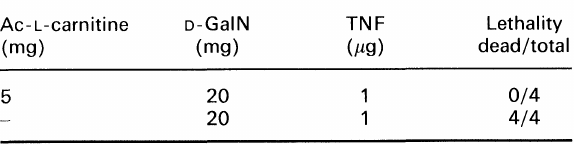
Table 9. Effect of acetyI-L-carnitine on the lethal activity of TNF# in D-GaIN sensitized mice